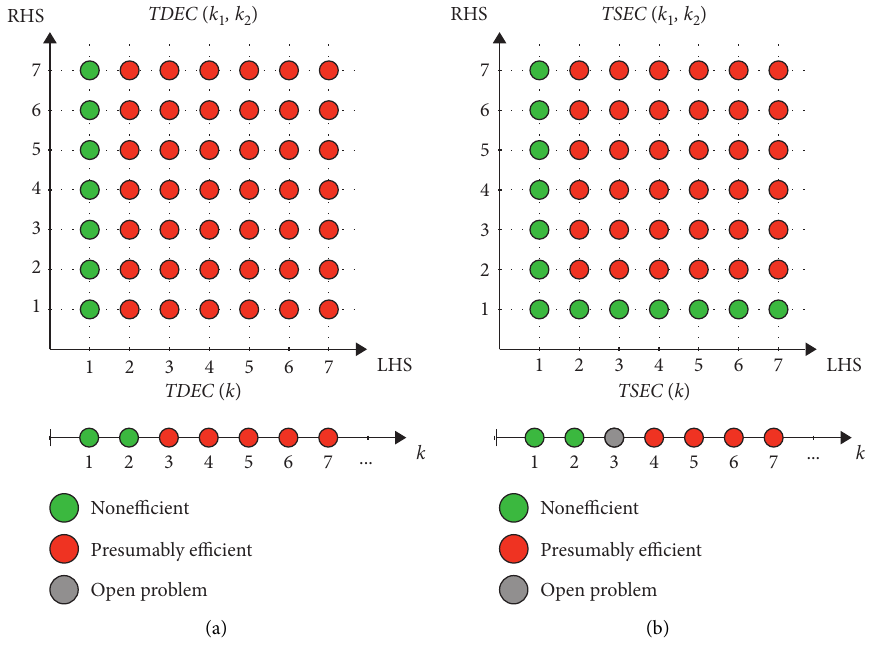
Figure 1: Known complexity results on tissue P systems with evolutional symport/antiport